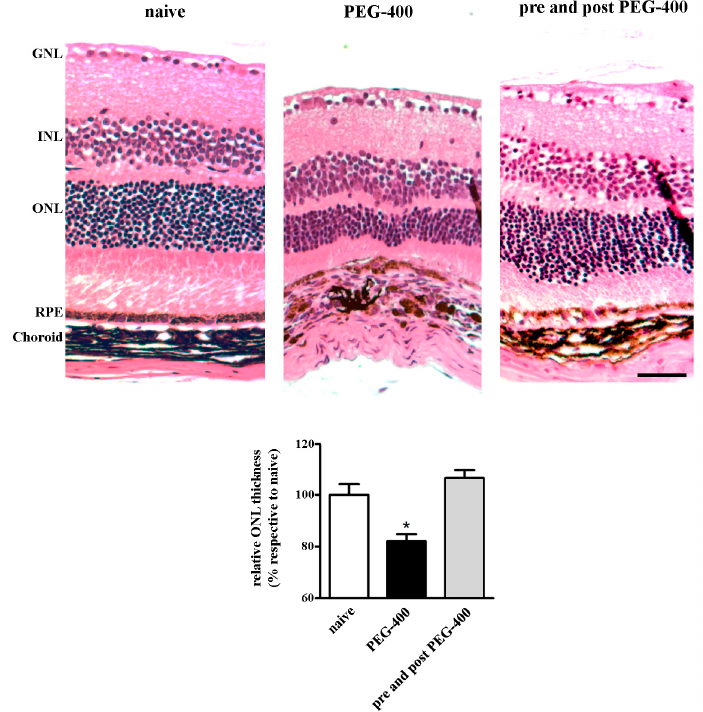
Figure 5. mFAG dietary supplementation ameliorates PEG-400-induced retinal damage. Illustrative H and E images of eyes from mice untreated (naive) or subretinally injected with 0.5 mg PEG-400 in the absence (PEG-400) or presence (pre- and post-PEG-400) of mFAG dietary supplementation pre- and post-PEG-400. Measurements of the ONL thickness were normalized to total retinal thickness and plotted versus naive, as the mean ± S.E.M. ( n = 5, 8, or 11, respectively per group). * p < 0.05 (one-way ANOVA followed by Newman-Keuls multiple comparison post-hoc test). Scale bar = 50 µ m. Retinal layers: GNL, ganglion nuclear layer; INL, inner nuclear layer; ONL, outer nuclear layer; RPE, retinal pigment